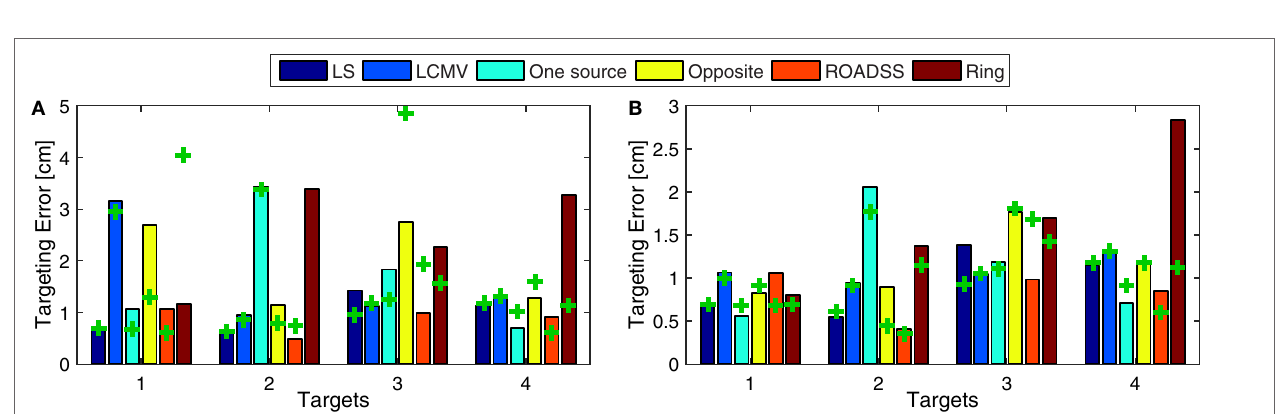
FIGURE 12 | Targeting Error (TE). Distance between the global (A) , and local (B) center of gravity and the true central position of the target, for the 256 EGI electrode net (bars) and for the 128 EGI electrode net (“ + ” marks). Global TEs larger than 5cm were removed for clarity.